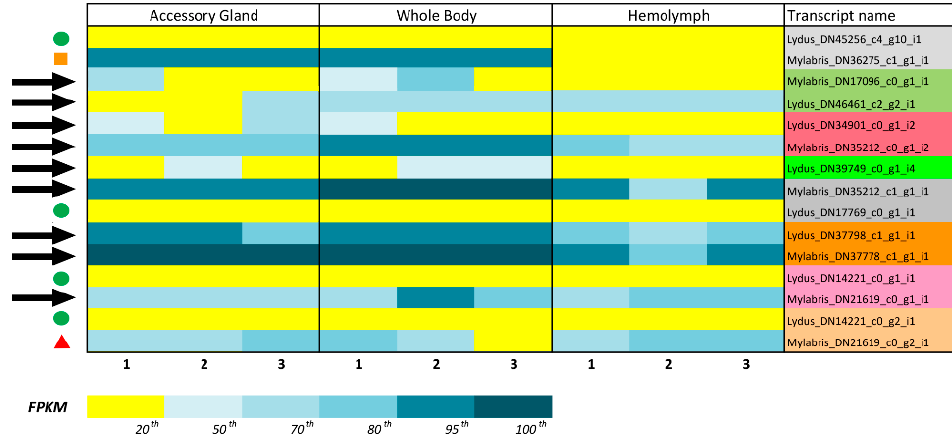
Figure 3. Gene expression for Kunitz transcripts based on RNAseq analysis [33]. Results are visualized as percentile of FPKM; black arrows, transcripts selected for cloning; green circles, transcripts excluded for low expression; orange square, transcript excluded for lack of the initial Met; red triangle, transcript excluded for very high sequence homology with a selected transcript (Mylabris_DN21619_c0_g1_i1 98% homology). Orthologous sequences from L. trimaculatus and M. variabilis are highlighted with the same colour.